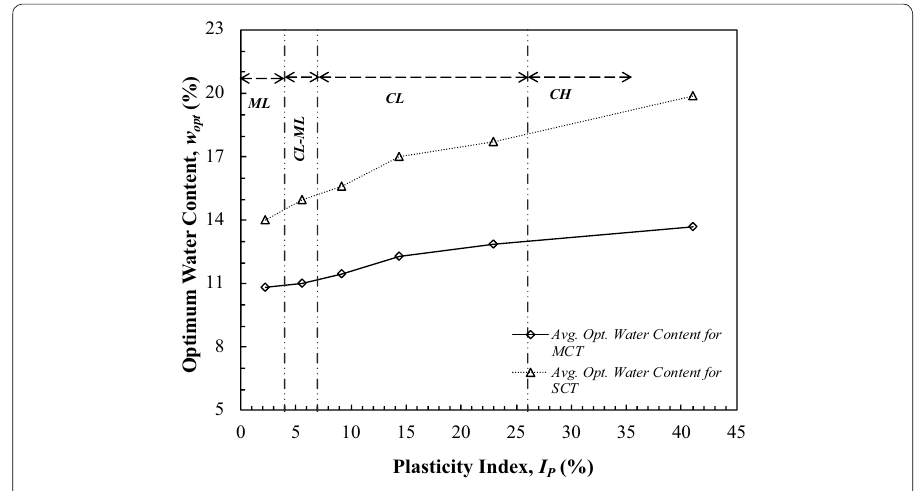
Fig. 6 Effect of plasticity index on optimum water